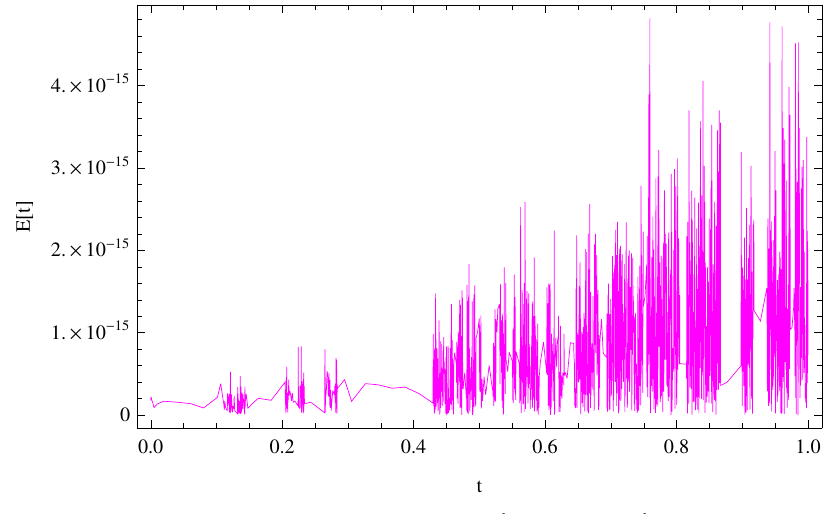
Figure 12. The E ( t ) of Example 5 for N = 8, λ = 1